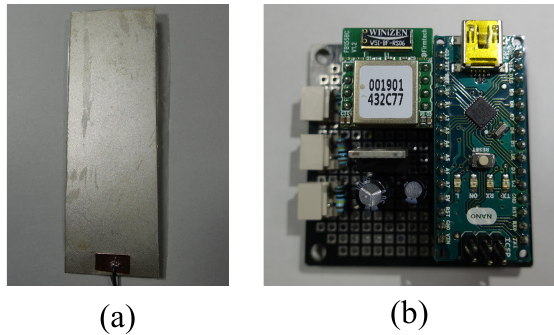
Figure 1. Pictures of the ( a ) flexible sensor and ( b ) sensing